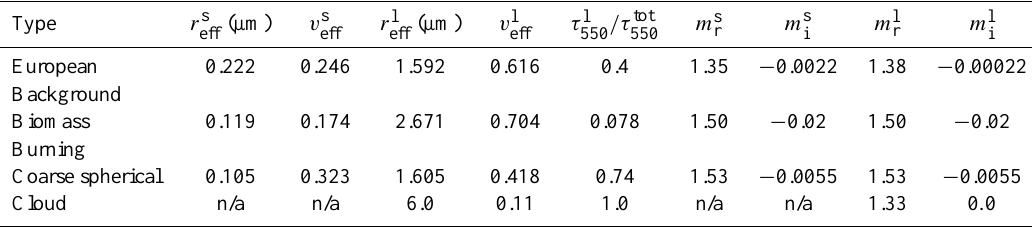
Table 1. Aerosol/cloud types used to create synthetic measurements of intensity and polarization. The aerosol types “European Background” and “European Polluted” are taken from a model run of the ECHAM5-HAM aerosol model (Stier et al., 2005). The “Biomass Burning” and “Coarse spherical” aerosol types are taken from Torres et al. (2001) (where “Coarse spherical” is called “Dust”). r eff refers to effective radius, v eff , to effective variance, m r and m i to the real and imaginary part of the refractive index, respectively, τ 550 to the aerosol optical thickness at 550nm. Further, the superscripts “s” and “l” refer to the small and large mode, respectively. r l τ l /τ tot m s Type r s (µm) v s (µm) v l eff eff eff eff 550 550